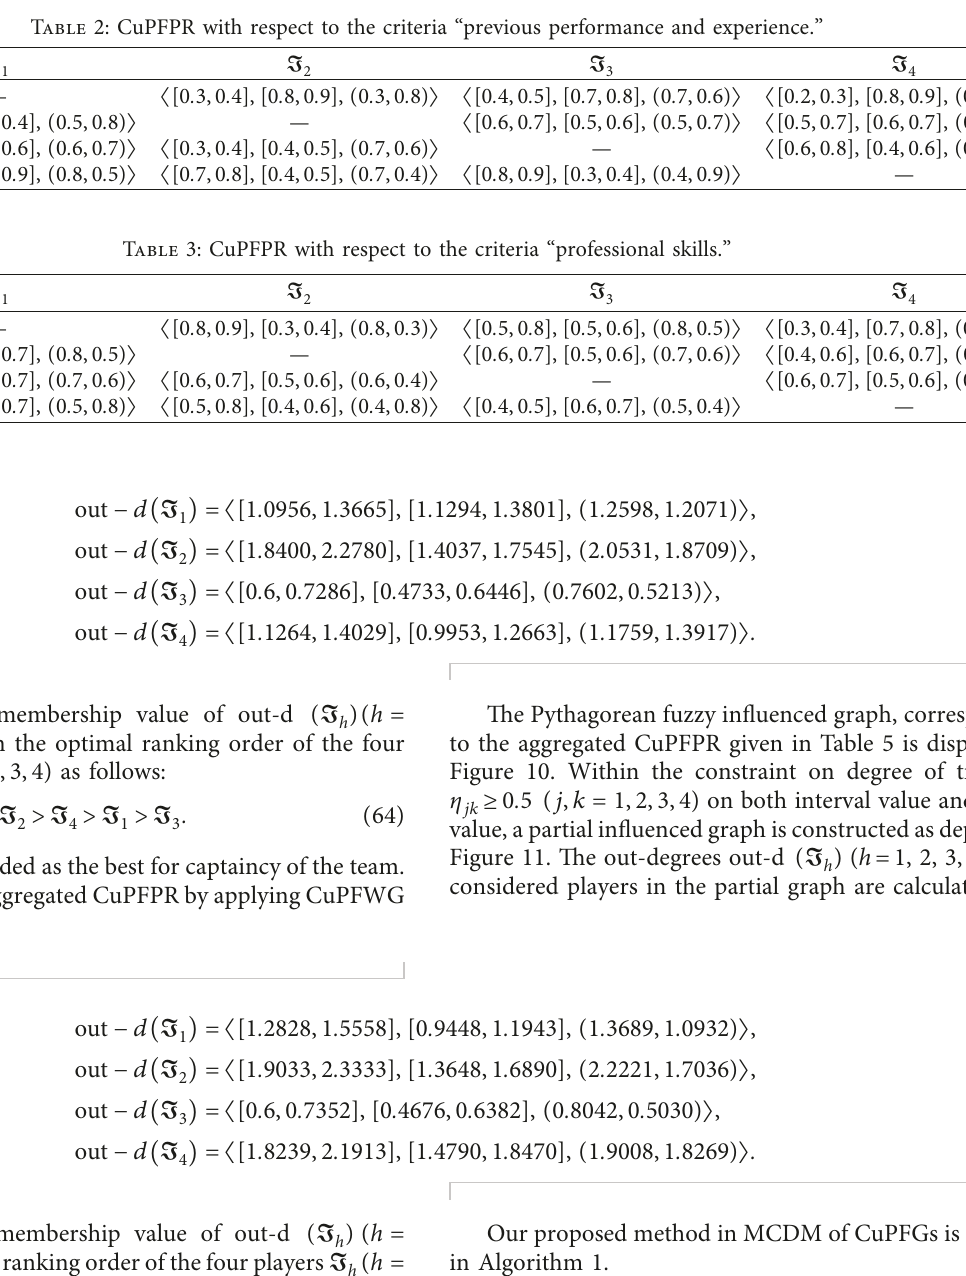
Table 2: CuPFPR with respect to the criteria “previous performance and experience.”